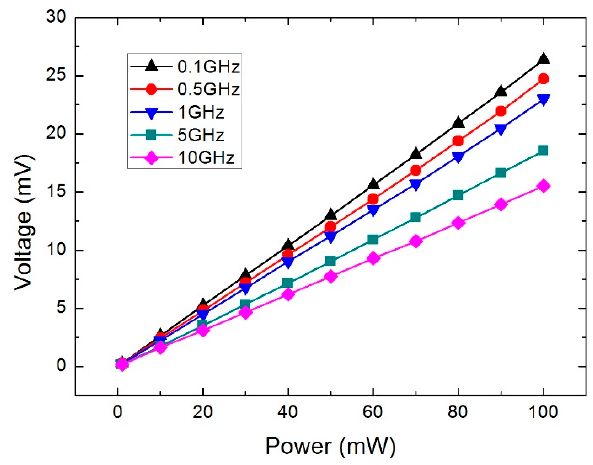
Figure 12. Measured voltage versus the incident power at 0.1 GHz, 0.5 GHz, 1 GHz, 5 GHz, and 10 GHz.